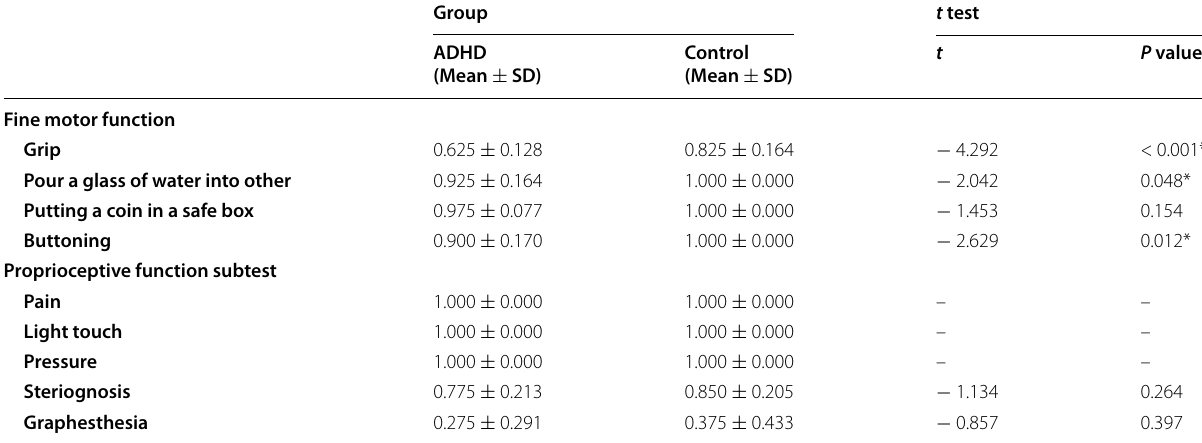
Table 3 Comparison between ADHD and control children regarding fine Motor Function and proprioceptive function subtest